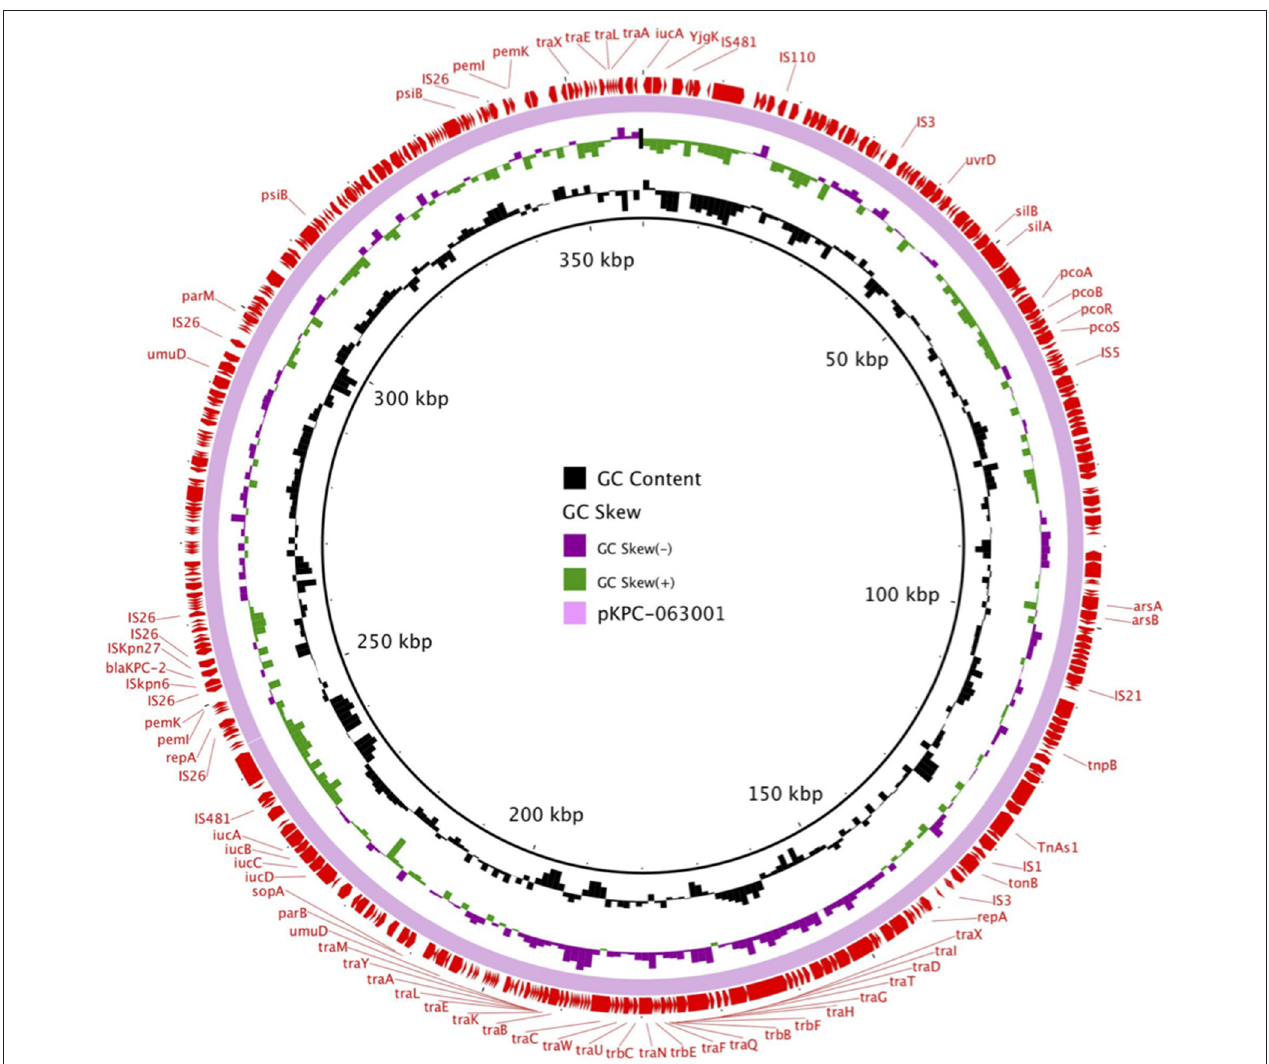
FIGURE 4 | The visual circle map of plasmid pKPC-063001, where bla KPC − 2 is located. GC content, GC skew + , and GC skew– are, respectively, indicated in black, green, and purple.